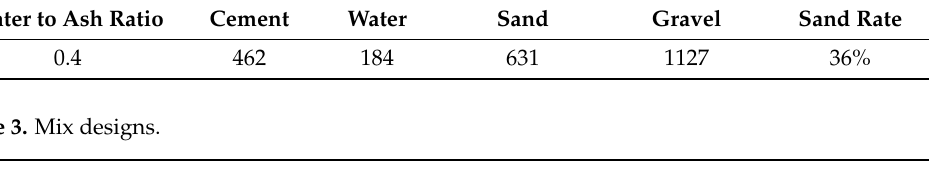
Table 2. Concrete mix ratio (unit: kg/m 3 ).